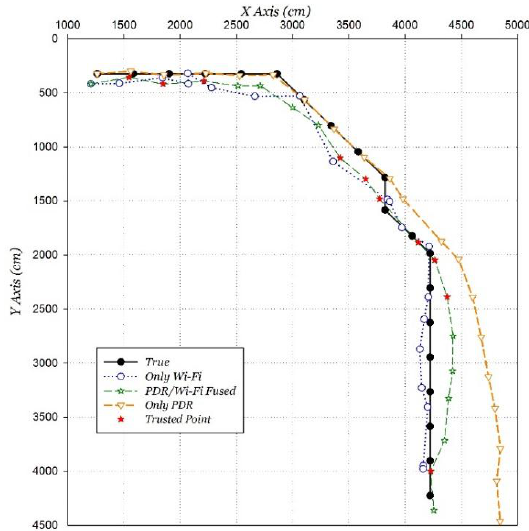
Figure 18. PDR/Wi-Fi fusion positioning result distribution.